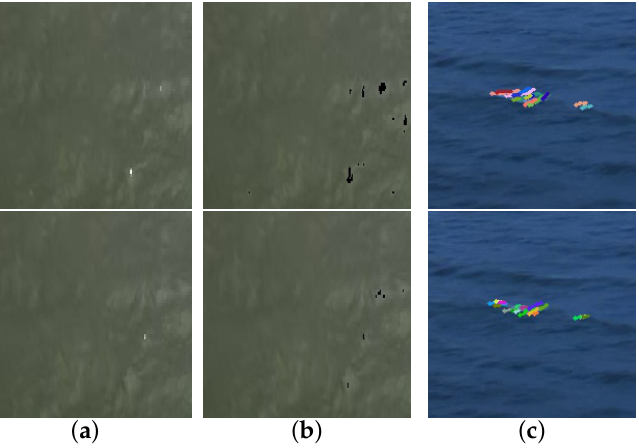
Figure 17. ( a ) The high-brightness sea surface, considered as abnormal with, ∆ t = 0.16 s ; ( b ) the abnormal area of ( a ), marked with black pixels; and ( c ) whitecap trajectories without any illumination pollution at f h and f l of the second row in Figure 9. ∆ t = 0.16 s